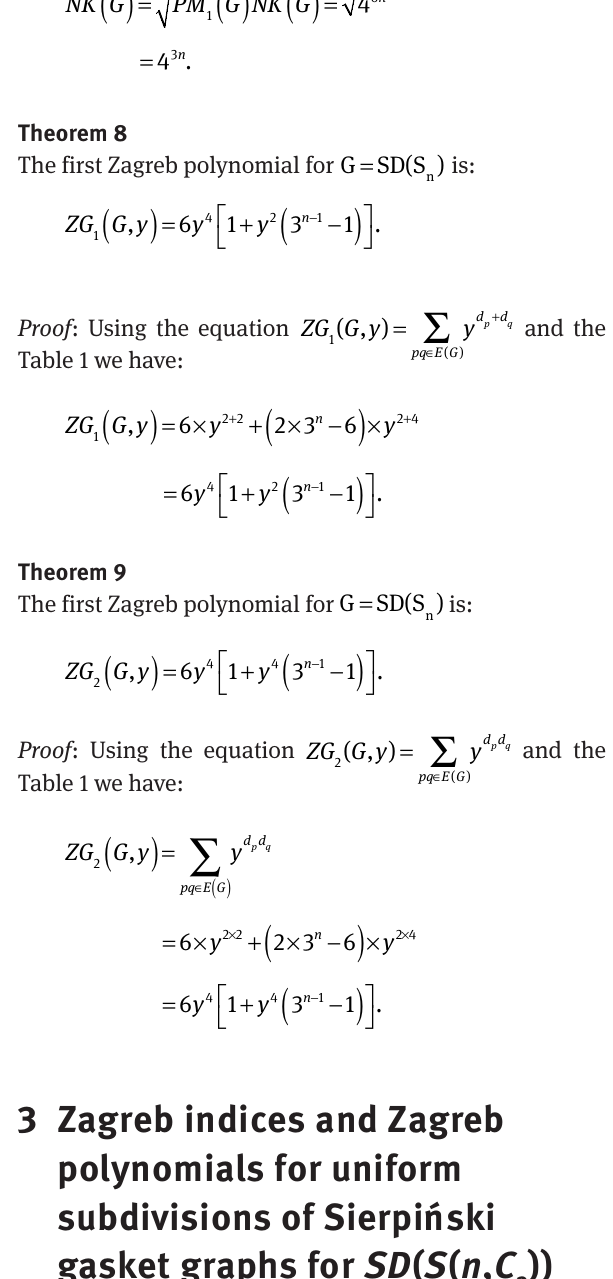
Table 3: The partition of E ( G ) of SD ( S ( n , C